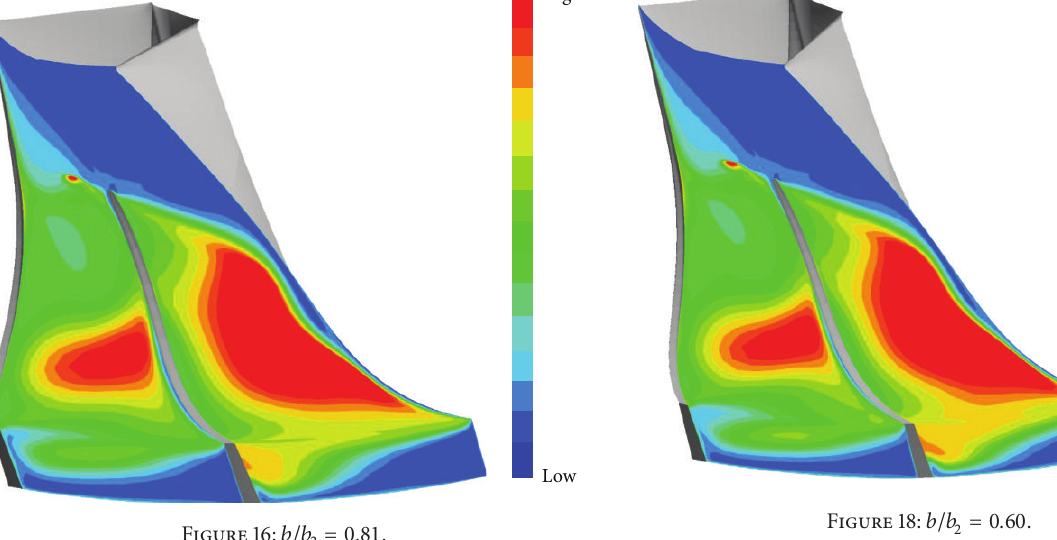
Figure 16: 𝑏/𝑏 2 = 0.81 .